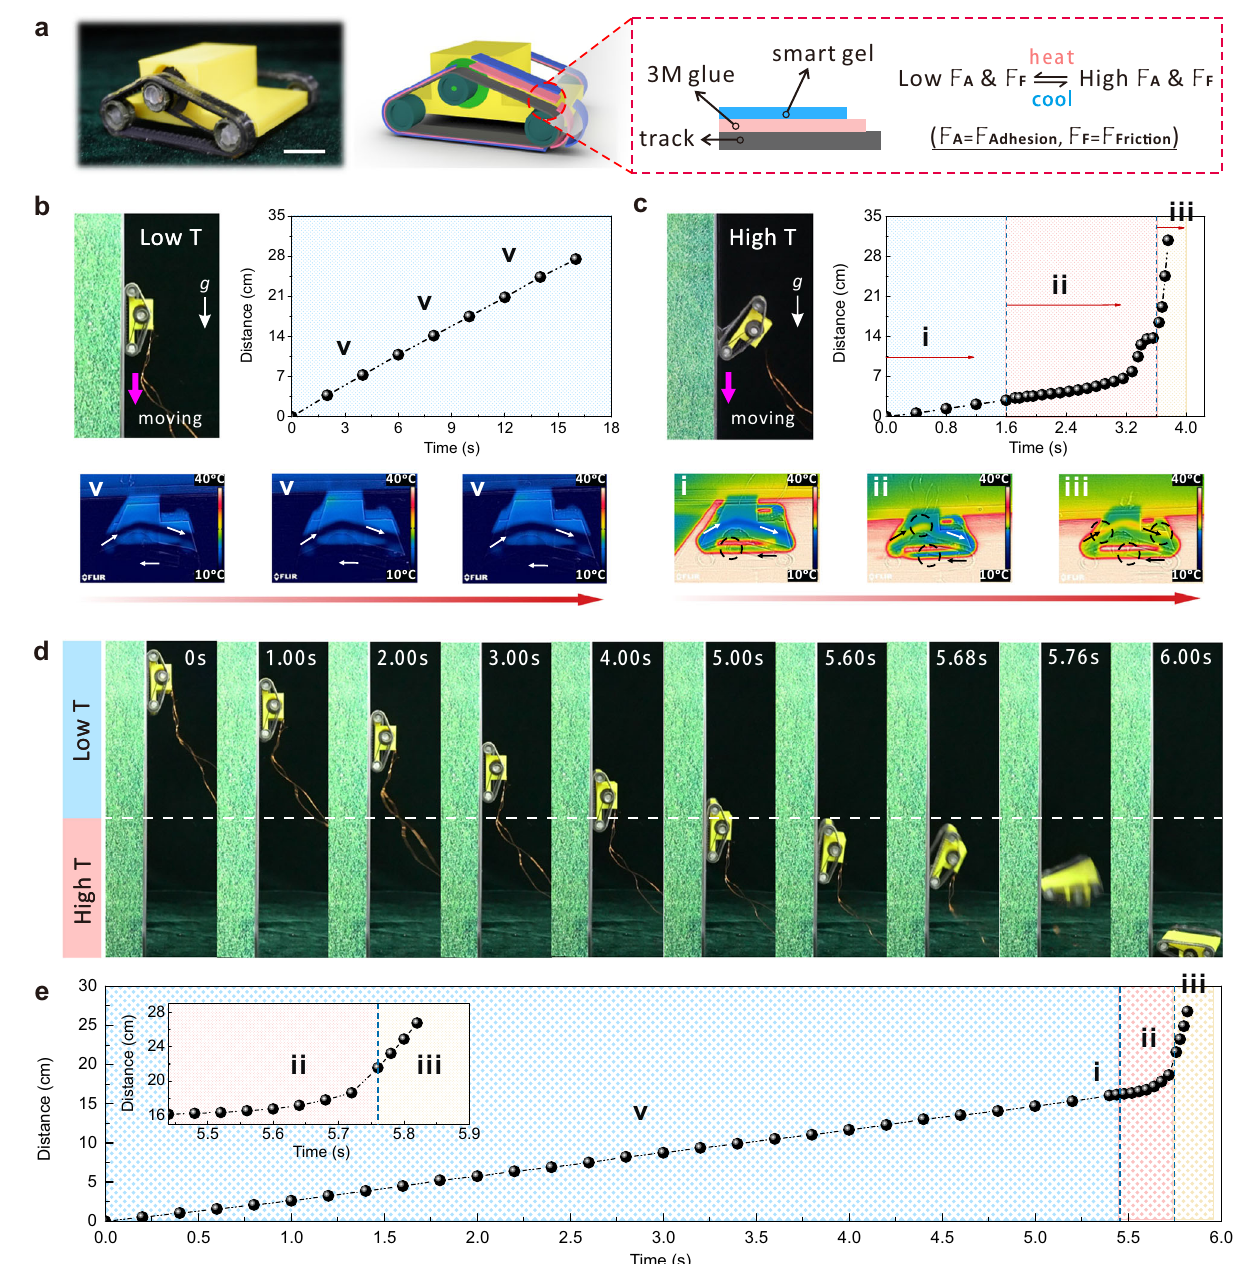
Fig.4|ApplicationofDMCS-hydrogelinamobiledevice.a Thephysicalimageof the mobile device manufactured using 3D printing technology. Its tracks were equippedwiththermallyresponsiveDMCS-hydrogelsthatcausedatransitionfrom high adhesion and high friction (High F A and F F ) to low adhesion and low friction (Low F A and F F ) during heating and cooling. Scale bar, 15mm. Motion capture images of the mobile device crawling on a vertical metal plate at low temperature ( b ) and high temperature ( c ), as well as the related time-distance curve. Infrared